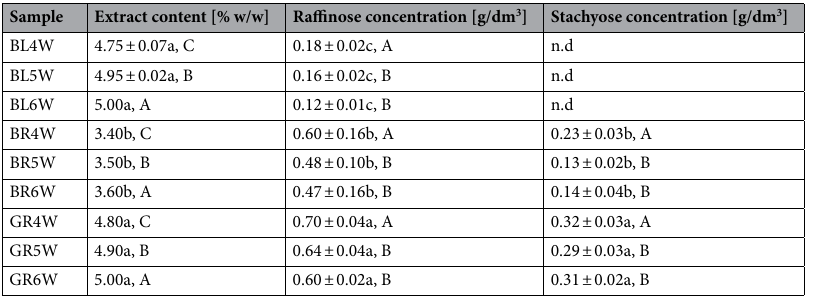
Table 3. Extract content and concentration of stachyose and raffinose in worts produced from lentil malts. Data are shown as means ± standard deviation (n = 6). Various small letters (a, b, c) indicate homogenous groups according to the variable ‘variety’, various capital (A, B) letters indicate homogenous groups between malts according to the variable ‘days of germination’ (Bonferroni test, α = 0.05). N.d. stands for “not detected”. BL4W wort from black lentil malt germinated 4 days, BL5W wort from black lentil malt germinated 5 days, BL6W wort from black lentil malt germinated 6 days, BR4W wort from brown lentil malt germinated 4 days, BR5W wort from brown lentil malt germinated 5 days, BRW6 wort from brown lentil malt germinated 6 days, GR4W wort from green lentil malt germinated 4 days, GR5W wort from green lentil malt germinated 5 days, GR6W wort from green lentil malt germinated 6